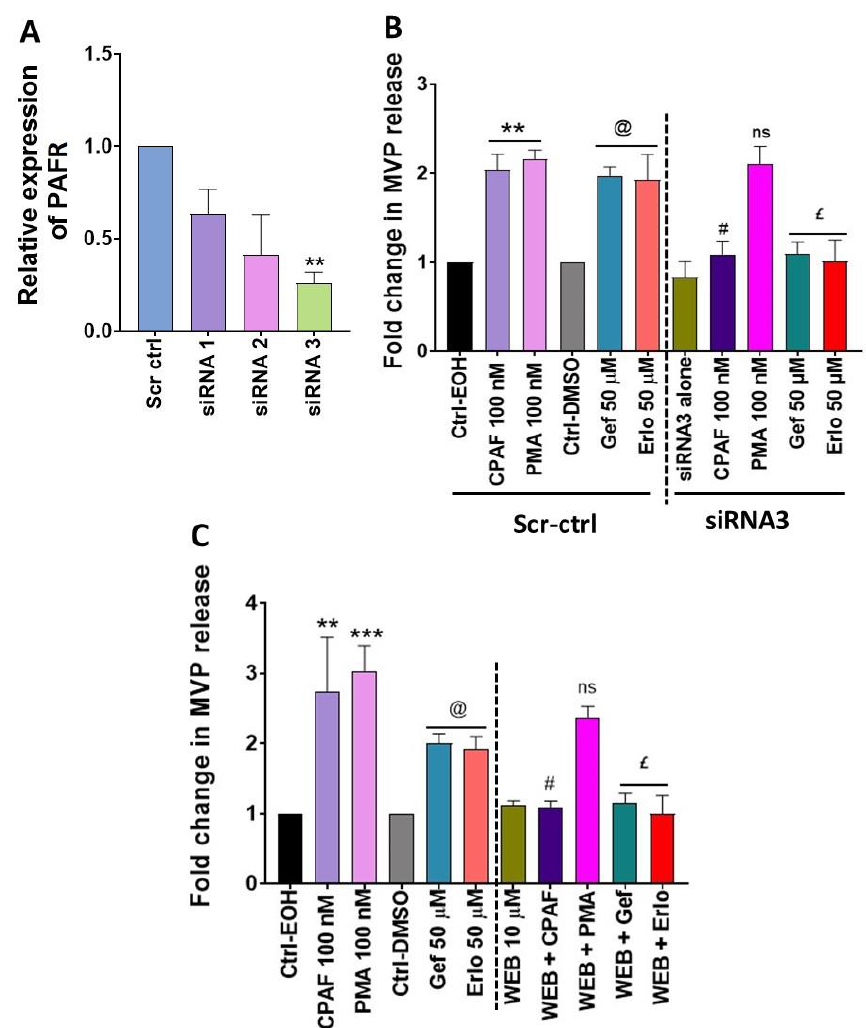
Figure 4. E ff ects of the PAFR-specific siRNA and PAFR antagonist on gefitinib and erlotinib-induced MVP release. ( A ) A549 cells were transfected with scrambled siRNA (i.e., Scr-ctrl) for control or three separate clones of PAFR siRNA and after 48 h, the PAFR knockdown e ffi ciency was evaluated by qPCR assay. ( B ) A549 cells were transfected with Scr-ctrl or PAFR siRNA clone 3 (i.e, siRNA3) and after 48 h treated with 0.1% EOH or DMSO as vehicle controls, 100 nM CPAF or PMA as positive controls, and 50 µ M Gef or Erlo. ( C ) A549 cells were pretreated with PAFR antagonist, WEB2086 (10 µ M, 1 h) followed by the treatments with or without CPAF, PMA, Gef, or Erlo at the given doses. After 4 h of incubation, MVPs were isolated and analyzed. Data are mean ± SE of three independent experiments, normalized per 1 × 10 6 cells, and represented as ( A ) Relative expression of PAFR over Scr-ctrl and 3 separate clones of PAFR siRNA, and ( B , C ) Fold change in MVP release over various treatment groups. The statistically significant di ff erences were observed between ( A ) Scr-ctrl and siRNA3 (** = p < 0.01), ( B ) Ctrl-EOH and CPAF or PMA (** = p < 0.01); ctrl-DMSO and Gef or Erlo (@ = p < 0.01); CPAF vs. siRNA3 + CPAF (# = p < 0.01); PMA vs. siRNA3 + PMA (ns); Gef vs. siRNA3 + Gef, and Erlo vs. siRNA3 + Erlo (£ = p < 0.01), ( C ) Ctrl-EOH and CPAF or PMA (** = p < 0.01, *** = p < 0.001); Ctrl-DMSO and Gef or Erlo (@ = p < 0.01); CPAF vs. WEB + CPAF (# = p < 0.01); PMA vs. WEB + PMA (ns); Gef vs. WEB + Gef or Erlo vs. WEB + Erlo (£ = p < 0.01); ns indicates non-significant changes between the analyzed groups.